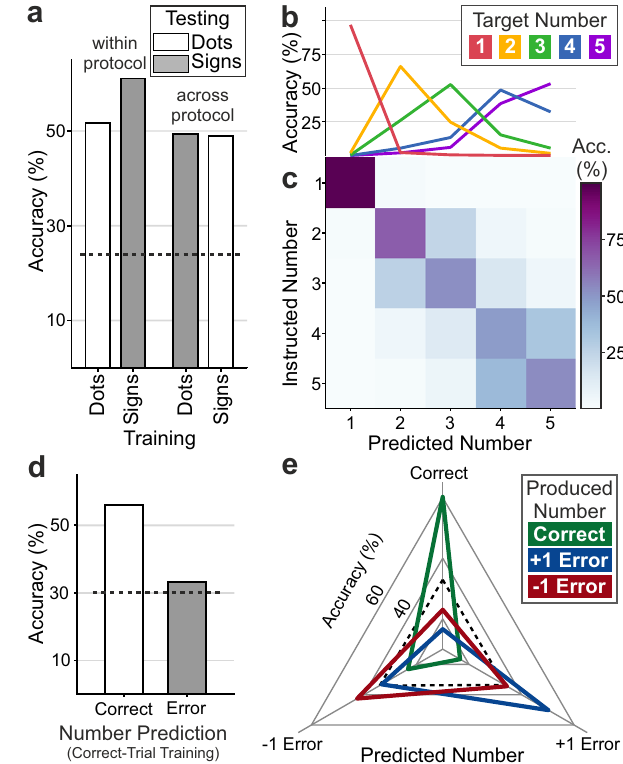
Fig. 4 | Population of NCL neurons represents the impending number of actions. a Incidence of selective neurons preferring each of the one to fi ve impending numbers of actions. b Neuronal population tuning functions for the motor planning period. Tuning functions of individual neurons were normalized and averaged according to preferred numerical value (color coded) in both sti- mulus protocols. Error bars indicate the SEM over neurons ( n =20, 15, 8, 18, 19 neurons for preferred numerical values 1 – 5, respectively). c Average neuronal population tuning curves plotted as a function of numerical distance from the respective preferred numerical values (distance 0). The same neurons ’ tuning during correct and incorrect trials are shown. Error bars depict the SEM where applicable( n =61neurons).Insetshowsaverage fi ringratetothepreferrednumber during correct and incorrect trials as boxplots ( n =61 neurons). d Average nor- malized neuronal activity ( n =33 neurons) in trials in which preferred target num- ber n was produced erroneously (gray boxes) instead of instructed ( n − 1 or n +1, respectively) pecking responses (white boxes: activity during correct trials). In Boxplots, the central lines depict the median, bounds of boxes demark the 1st and 3rdquartile,whiskersextendtotheminimumandmaximumvaluesnotconsidered outliers(>1.5 * interquartile range; not plotted). FR fi ring rate. Two-sided Wilcoxon sign-ranktestswereused.*** p =10 − 8 ;* p =0.02;n.s.notsigni fi cant( p =0.65).Source data are provided as a Source Data fi